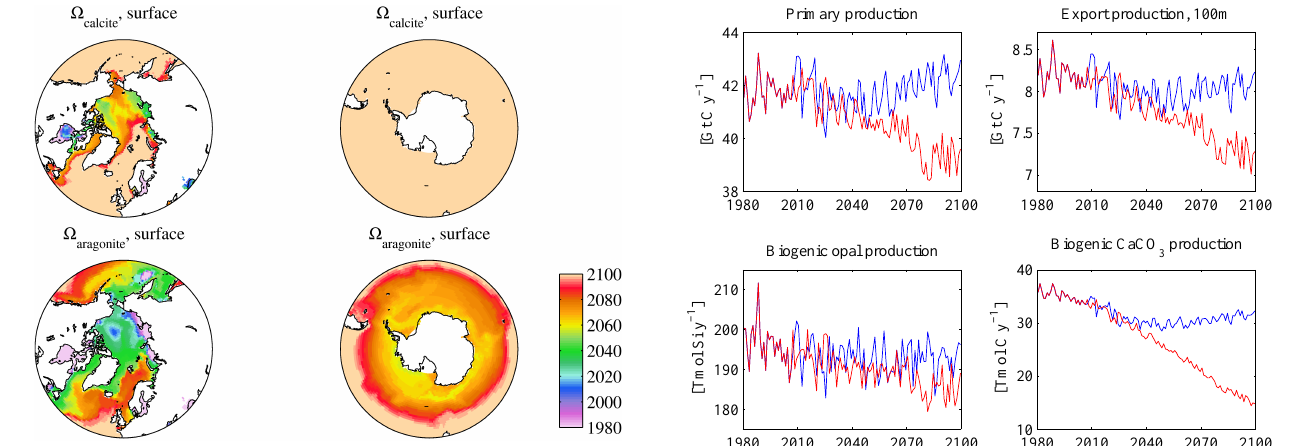
Fig. 20. Time evolution of integrated primary production (top left), Fig. 18. Time evolution of integrated primary production ( top left ), export production at 100m ( top right ), biogenic opalproduction( bottomleft )andbiogenicCaCO 3 production( bottomright ;–)forRCP2.6(blue)andRCP8.5(red). export production at 100m (top right), biogenic opal production (bottom left) and biogenic CaCO 3 production (bottom right) for RCP 2.6 (blue) and RCP 8.5 (red). Table 2. Upper 100m tracer concentrations, RCP 2.6 versus